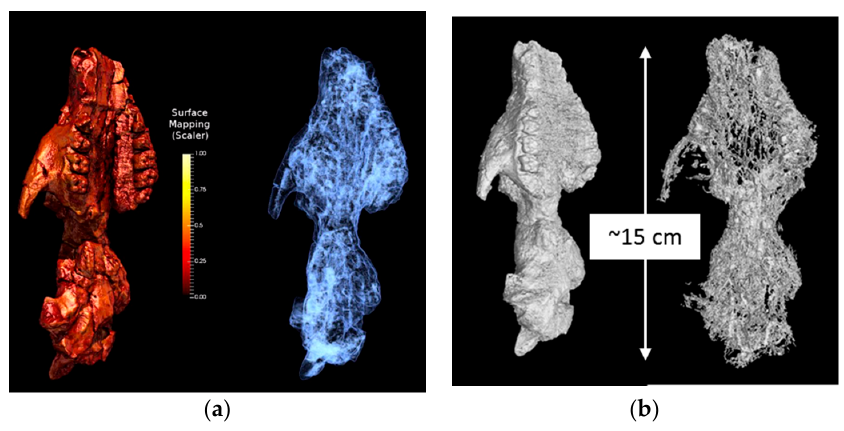
Figure 10. Thermal neutron ( a ) and hard X-ray CT scans ( b ) of a 62.3 million year old Tetraclaenodon puercensis . The surface (left in each part) and internal reconstructions (right) show the differences the two modalities provide.